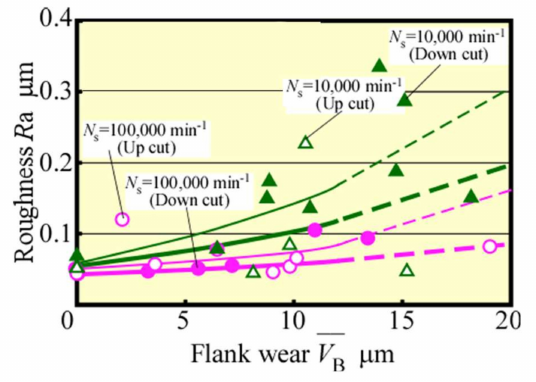
Figure 5. Surface roughness of the machined surface ( f = 5 µ m /